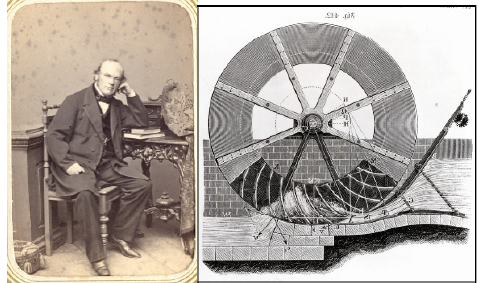
Figure 13. Julius Ludwig Weisbach (1806-1871) and his Description of the Poncelet‘s Water-Wheel in his Book Ingenieur- und Maschinenmechanik (1865)